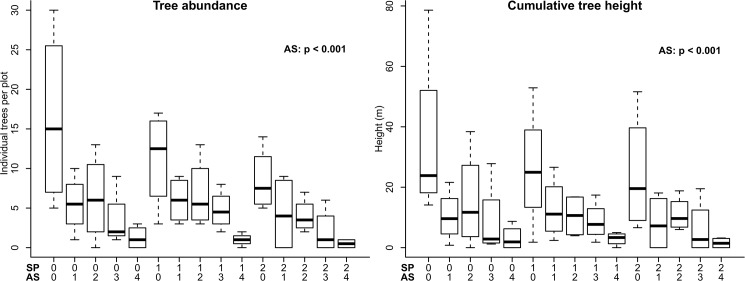
Abundance and cumulative height of trees according to experimental treatment at Towoomba in 2011/12.Box-plots show medians (dark bar), upper and lower quartiles (tops and bottoms of boxes), and ranges (upper and lower whiskers). AS = ammonium sulphate; SP = superphosphate. p values show the results of the Kruskal-Wallis testing for individual effects of AS and SP after Friedman testing for differences across all treatments.